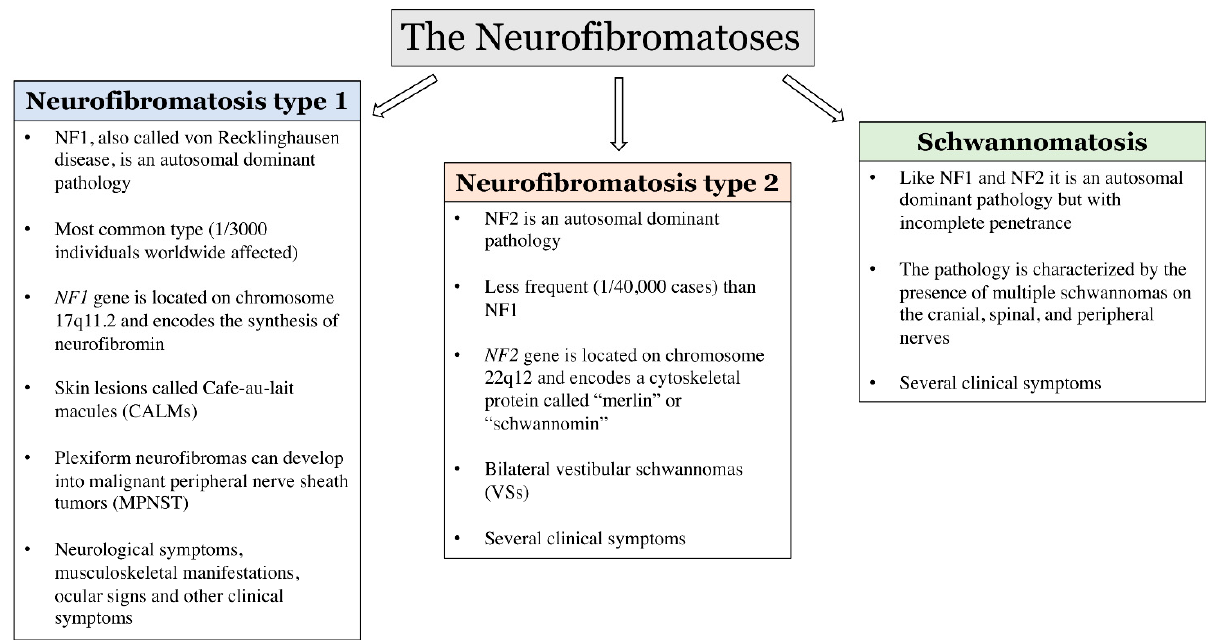
Figure 1. Neurofibromatoses. The figure schematizes and summarizes the main clinical and genetic characteristics of NF1, NF2 and schwannomatosis.